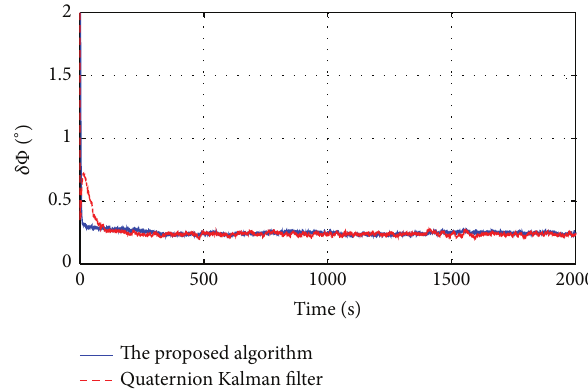
Figure 4: Monte-Carlo means of 𝛿Φ over 100 runs.